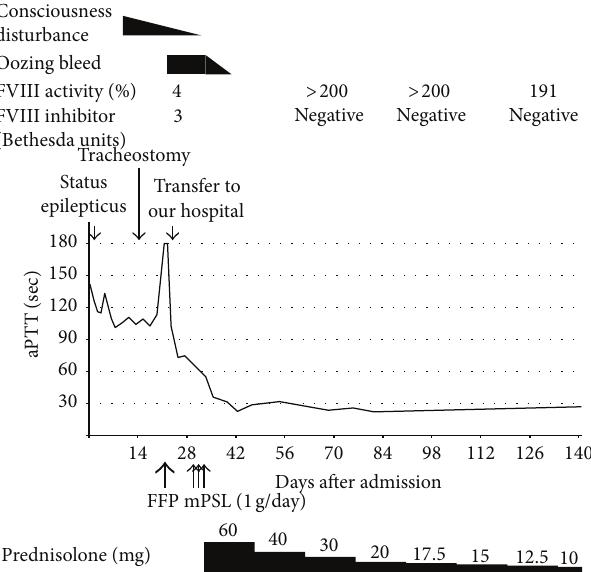
Figure 2: The clinical course. aPTT: activated partial thromboplas- tin time, FVIII: factor VIII, FFP: fresh frozen plasma, and mPSL: methyl